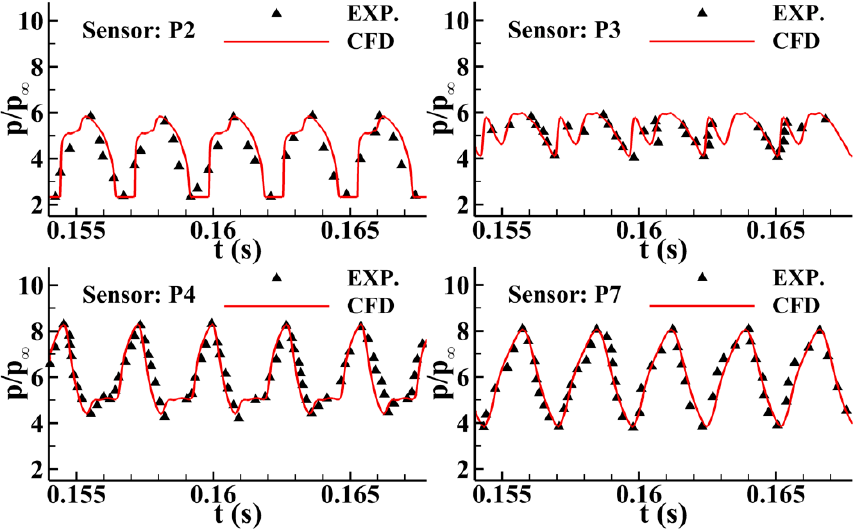
Figure 5. Pressure histories of experimental [2] and numerical results at different sensors.